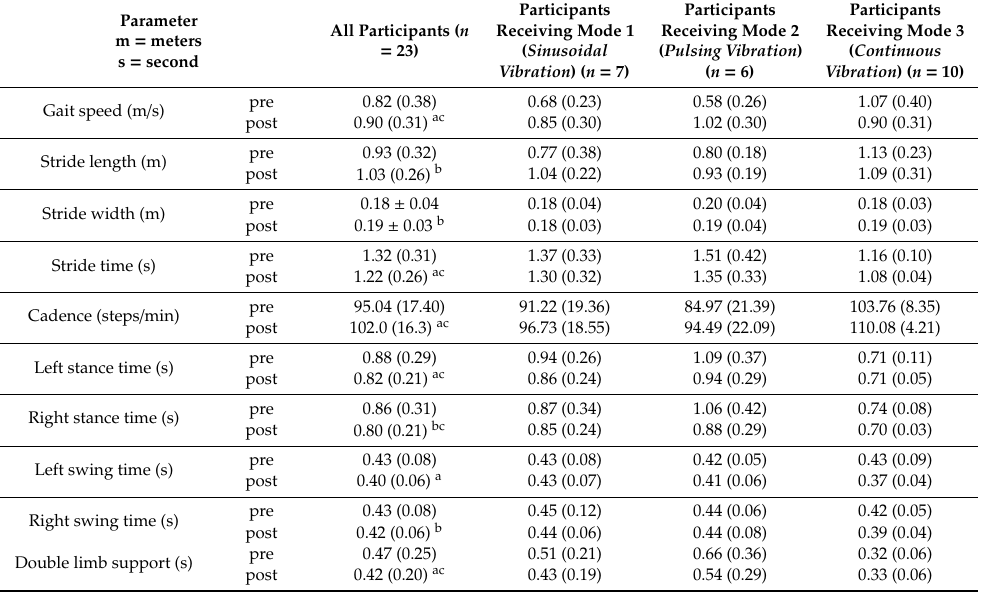
Table 2. Mean (std) in spatiotemporal parameters for all participants and for the three vibration mode groups.